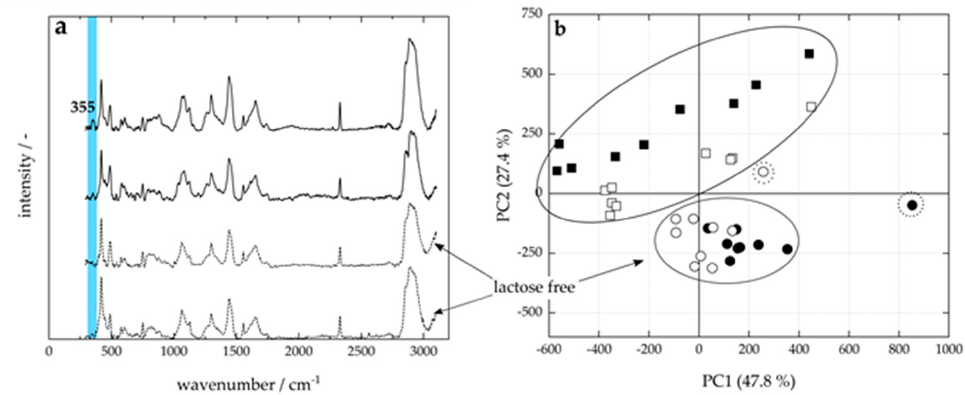
Figure 3. Representative smoothed Raman spectra of two lactose-free samples (<0.1 g per 100 g) (dashed lines) and two regular milk samples (solid lines) ( a ), and the resulting PCA score plot of PC1 vs. PC2 ( b ). Spectra are offset for clarity. Highlighted in blue is the band at 355 cm − 1 assigned to lactose.